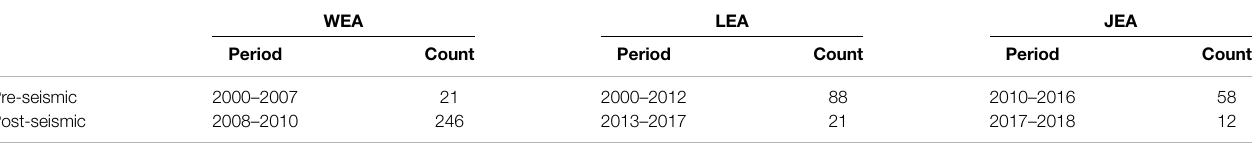
TABLE 1 | Debris- fl ow numbers and the time range in each